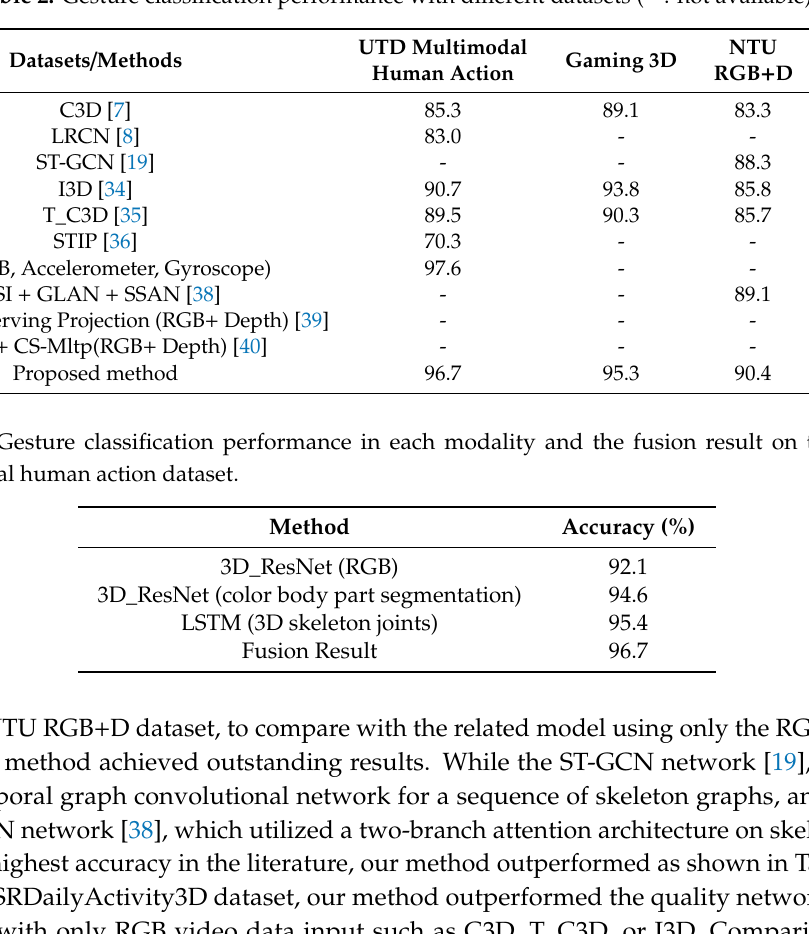
Table 2. Gesture classification performance with di ff erent datasets (‘-‘: not available).